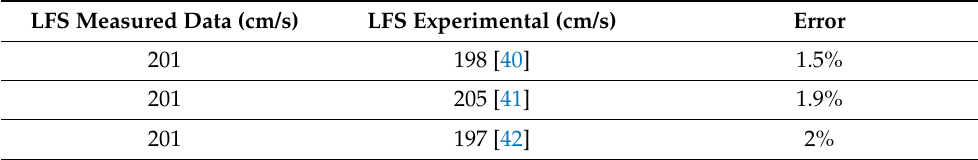
Figure 2. Validation of model by cylinder pressure and Heat Release Rate (HRR) for 100% gasoline port fuel injection. Reproduced with permission from Pamminger, M., etc., Proceedings of the ASME 2016 Internal Combustion Engine Division Fall Technical Conference; published by ASME, 2016 [37]. Table 6. Validation of LFS against measured data for R CNG =